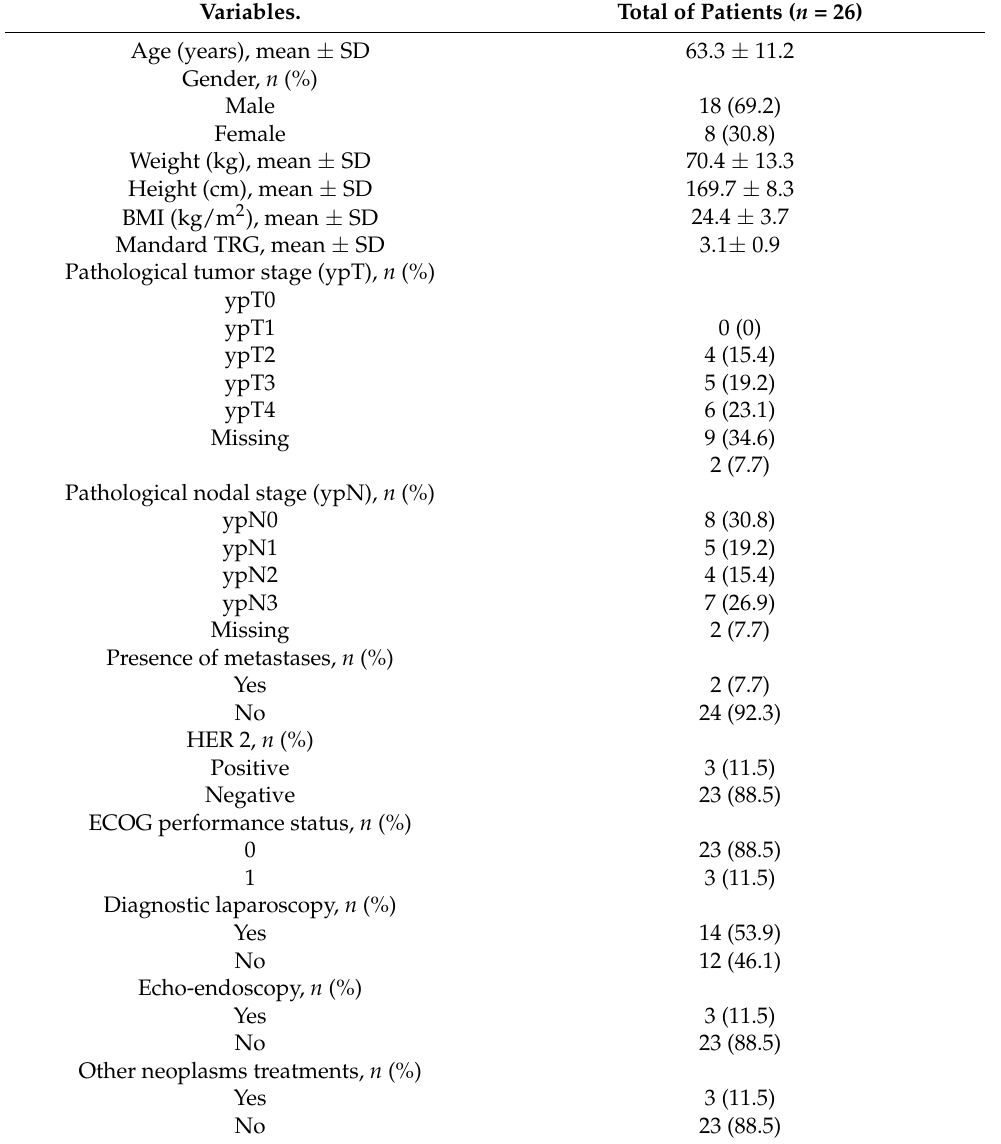
Table 1. Patients’